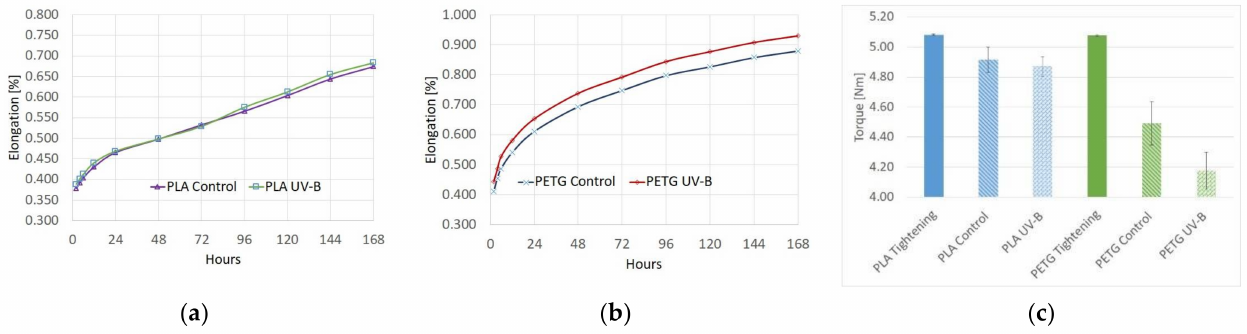
Figure 7. Creep curves of tested materials: ( a ) PLA elongation vs. time; ( b ) PETG elongation vs. time; ( c ) compression creep test untightening torque